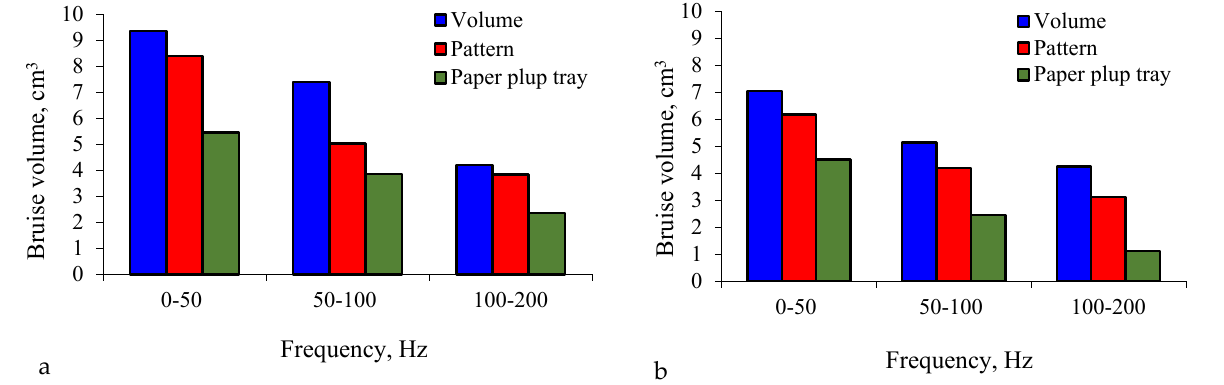
Figure 15. The effect of the packaging method on the bruise volume of cantaloupe at different vi- bration frequencies and durations: ( a ) 5 min; ( b ) 10 min.